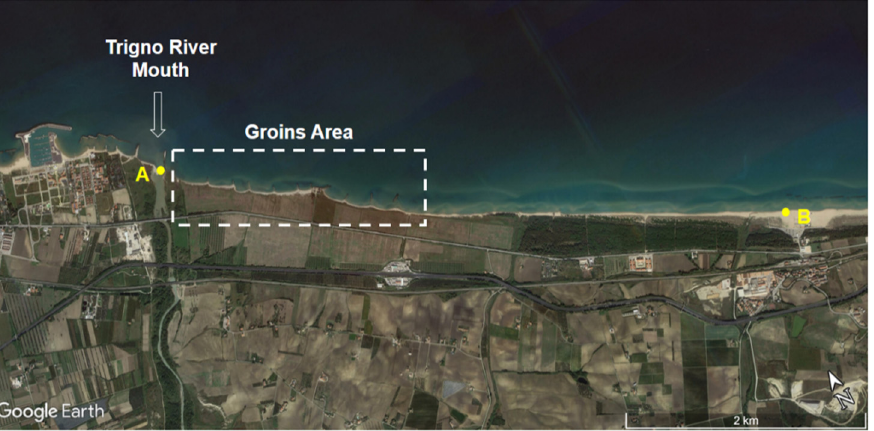
Figure 2. The study area (from A to B, 5.2 km) located just south of the mouth of the Trigno river. The northern part is covered by an 11-groin field.